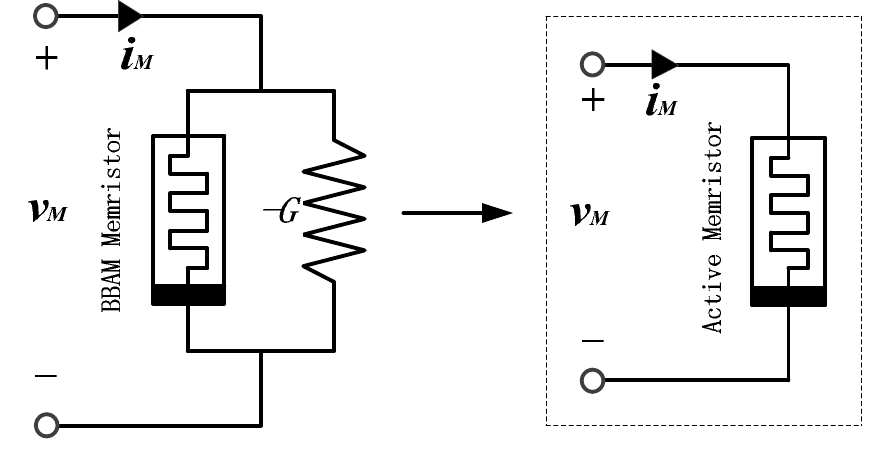
Figure 1. Sketch map of the active memristor.